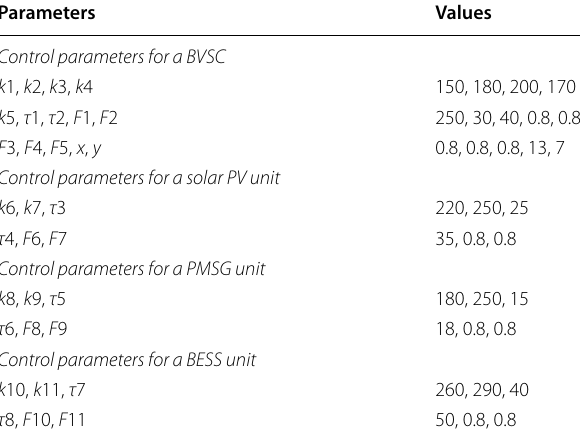
Table 2 Control parameters of the proposed control scheme Parameters